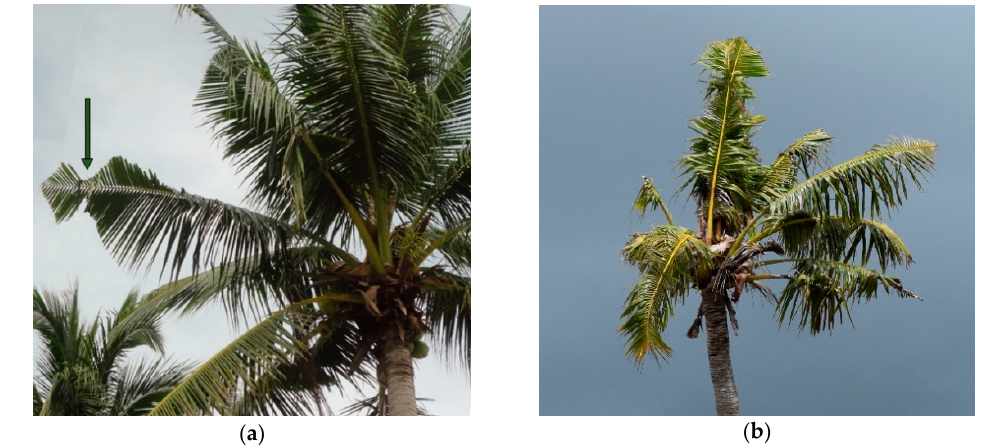
Figure 1. The appearance of coconut leaves following herbivory by coconut rhinoceros beetle (CRB). ( a ) CRB herbivory in northern Samar, Philippines showing characteristic sparse damage in the geographic regions where CRB is native (green arrow); ( b ) CRB herbivory on Guam showing the extensive health-compromising damage in geographic regions where CRB is invasive.